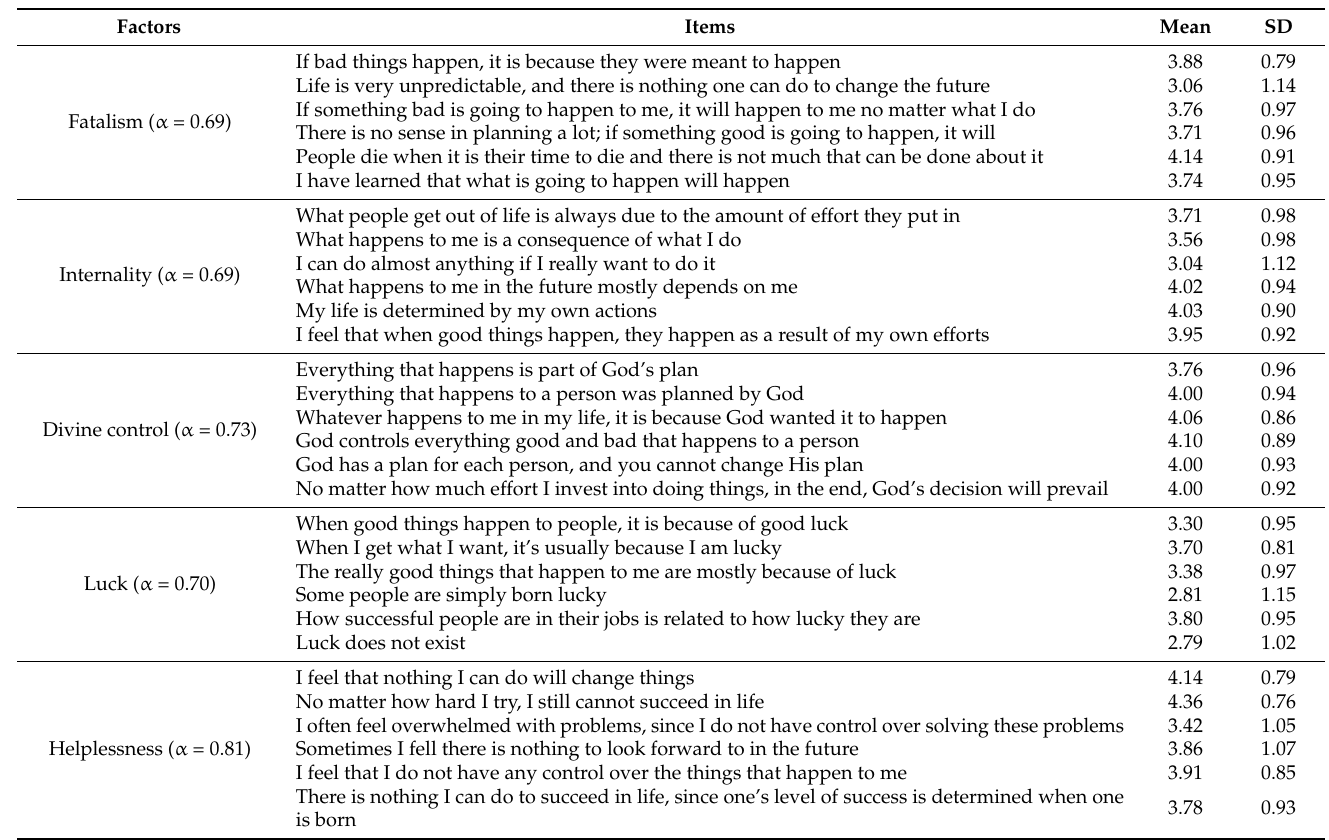
Table 4. The alpha values, means and standard deviations for fatalistic beliefs.